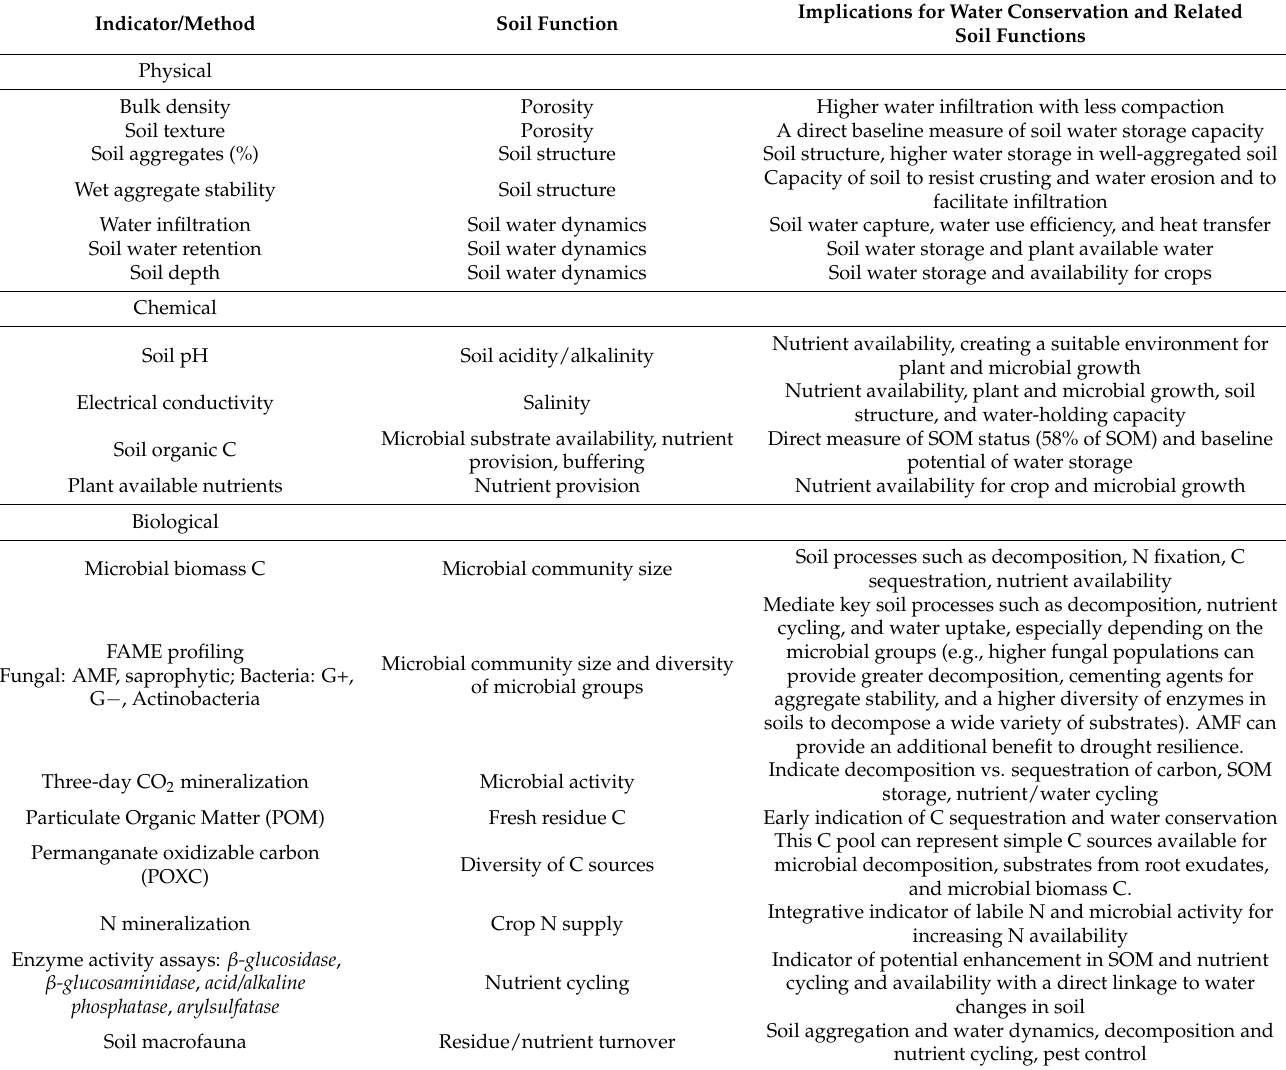
Table 1. Soil health indicators, their functions, and their implications for soil water